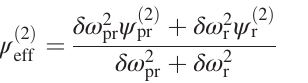
ω (solid, red) and F (dashed, black) evaluated at the first order p 0 Þ Gauss ð p 0 Þ (solid, red) and f ð ω (dashed, black), p 0 Þ p 0 Þ